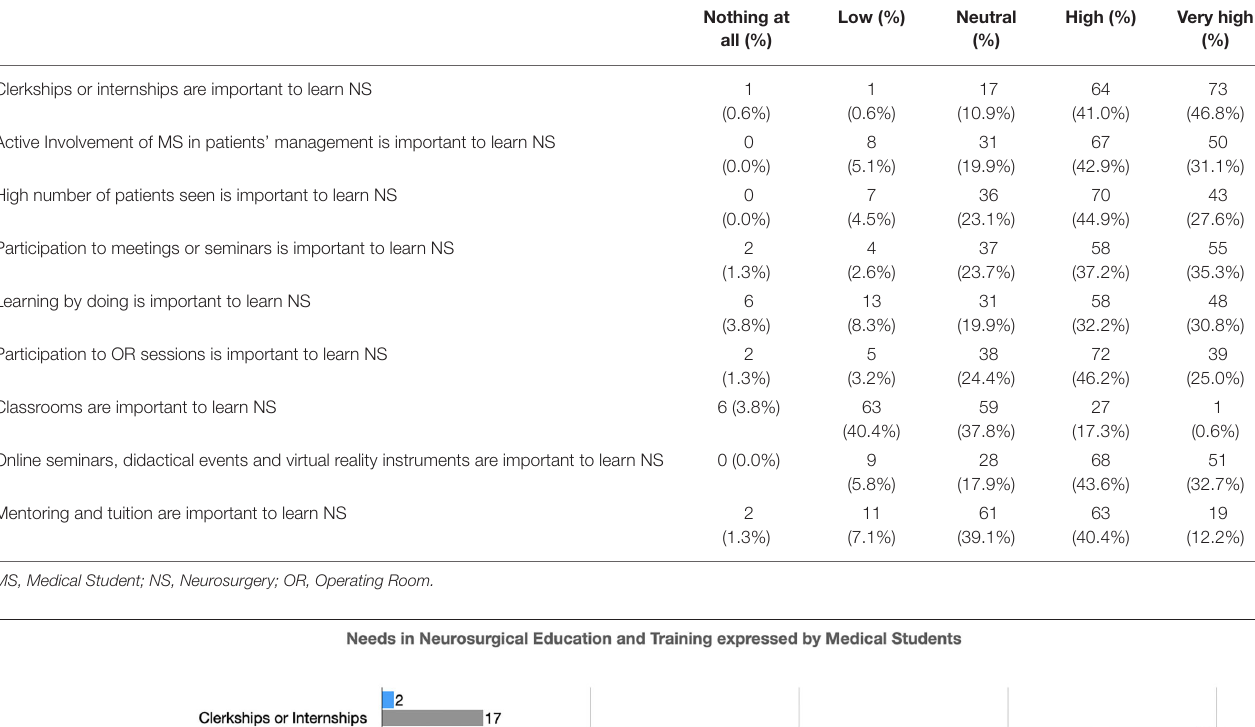
Nothing at Low (%) Neutral High (%) Very high all (%) (%) (%)